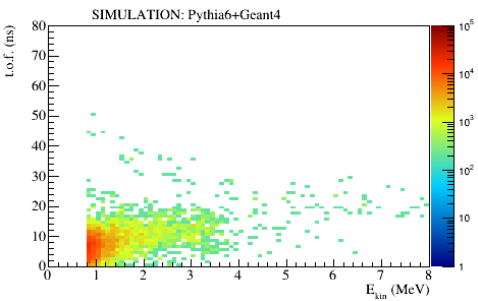
Figure 2: Results of the simulation for the time of flight vs deposited energy of charged pions reaching the silicon detectors of the Hjet